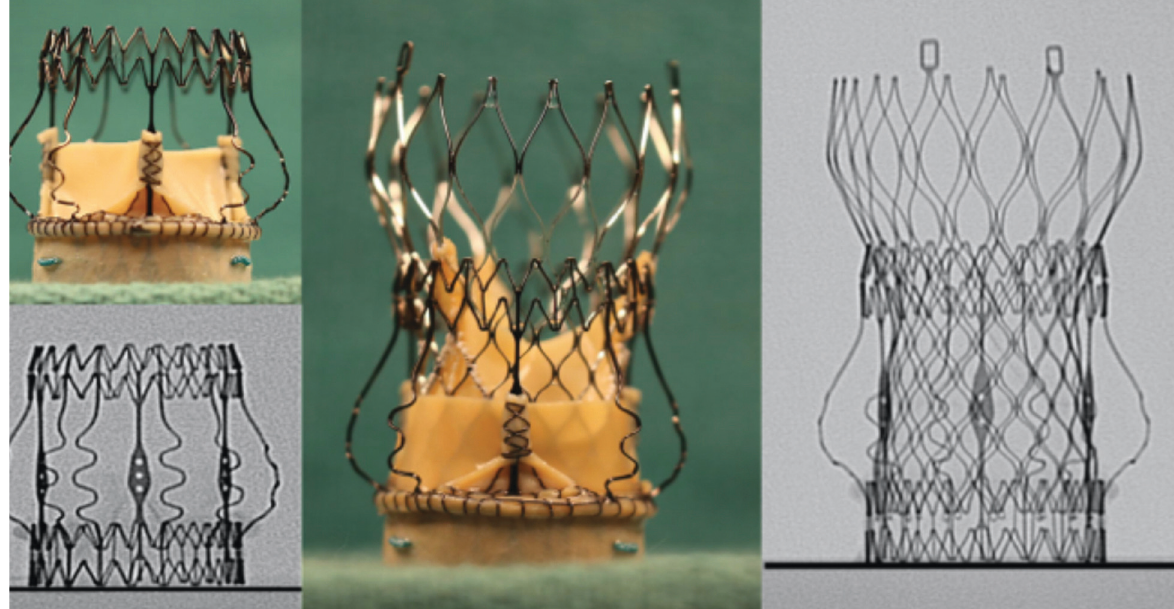
Figure 6: ViV App suggestion of depth of implantation of an Evolut R 23mm in a Perceval